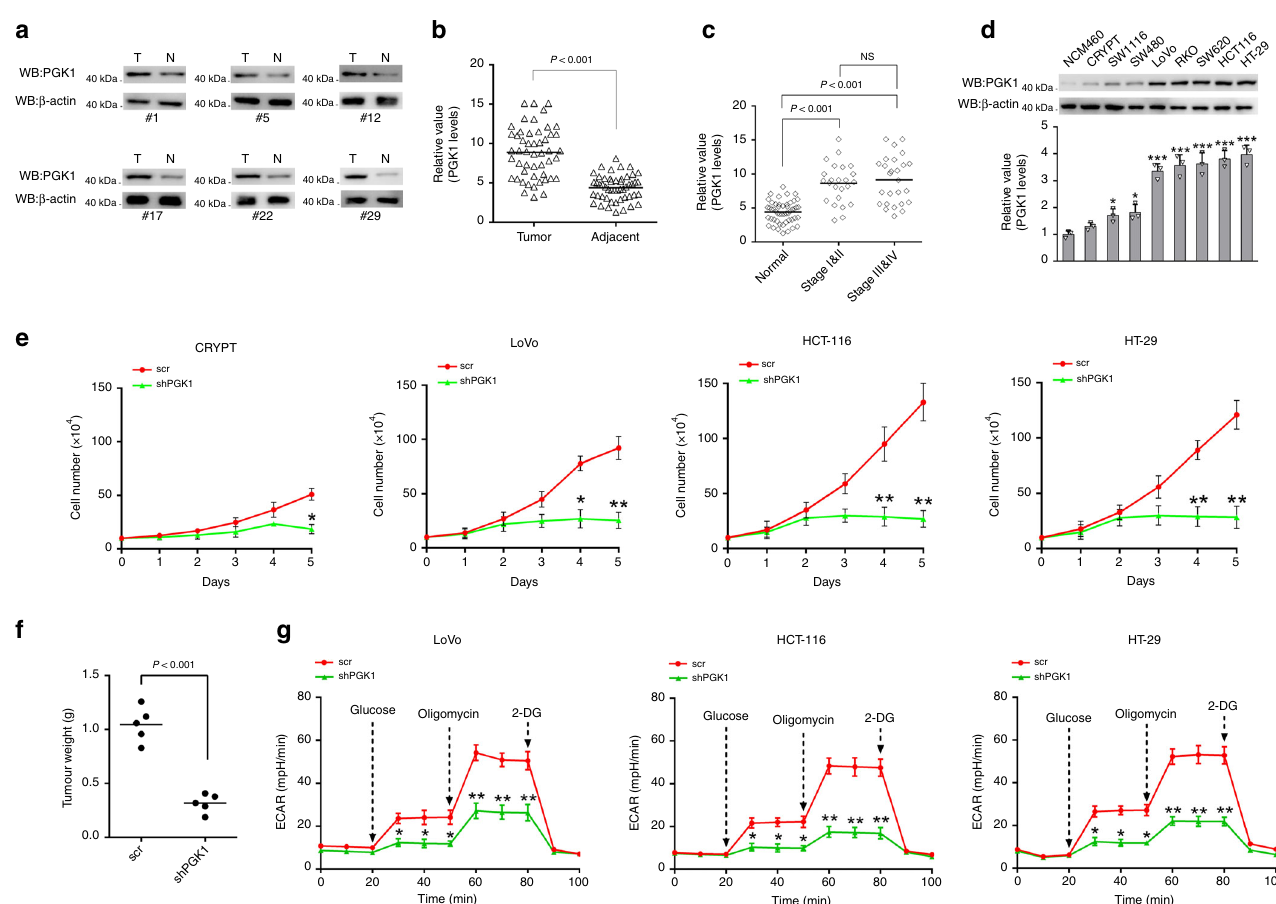
Fig. 1 PGK1 expression is important for colon cancer development. a Immunoblotting analysis of PGK1 protein expression in 6 represented peritumoral/ tumor tissue pairs from colon cancer patients. b Quantitative analysis of PGK1 expression showing signi fi cant increase in tumor tissues compared to the matching peritumoral tissues. c Quantitative analysis of PGK1 expression among different progression stages. d Immunoblotting analysis of PGK1 expression using a panel of colon cancer cell lines and two normal colon cell lines NCM460 and CRYPT. Quantitation of relative expression levels was shown. e Cell proliferation of CRYPT, LoVo, HCT-116 and HT-29 cells upon depletion of PGK1 using small hairpin RNA (shRNA). f Tumor weights